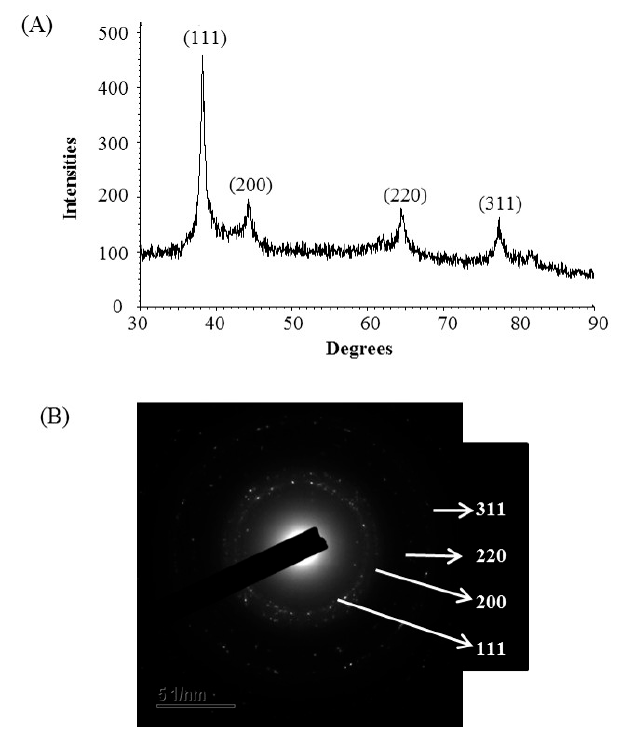
Figure 5. X-ray diffraction pattern ( A ) and selected area diffraction (SAED) pattern ( B ) of ecofriendly synthesized AgNPs.